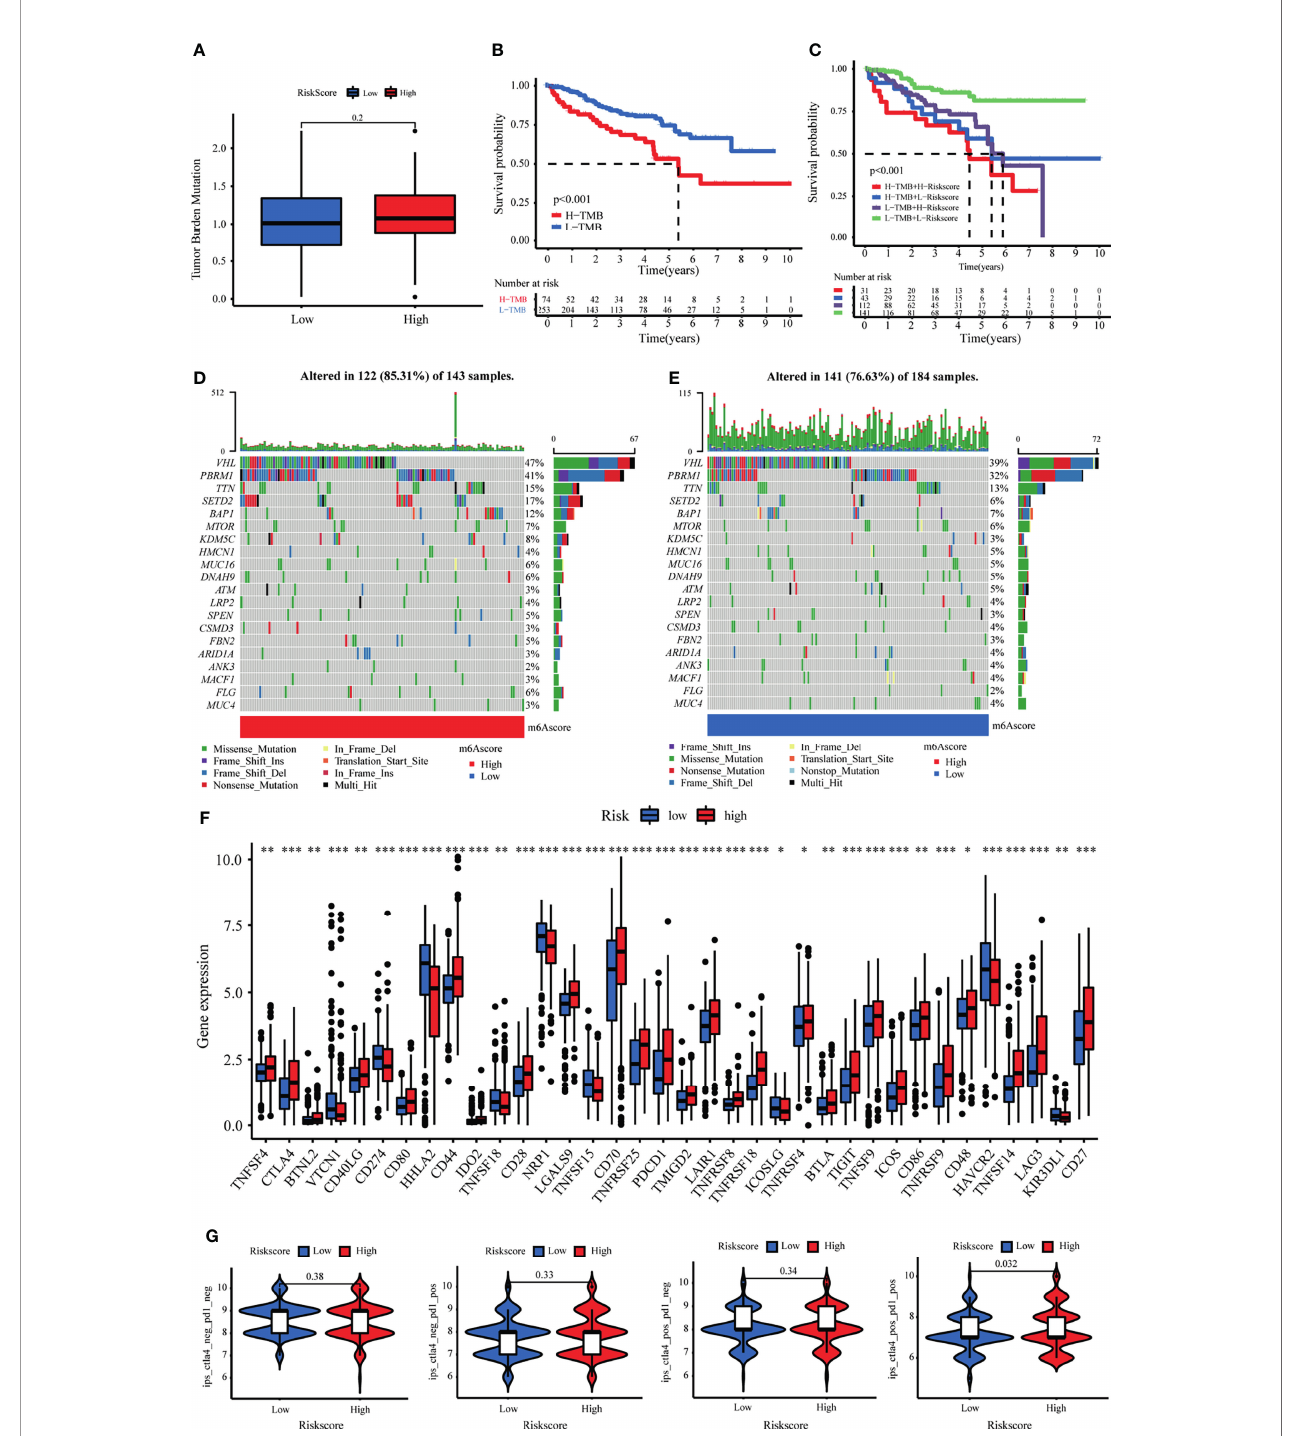
FIGURE 8 | Tumor mutational burden (TMB) and immunotherapeutic responses of the lactate-related prognostic signature (LRPS). (A) TMB between the low- and high-risk subgroups based on LRPS. (B) Survival analysis of the different groups strati fi ed by TMB. (C) Survival analysis of distinct groups strati fi ed by both TMB and LRPS. (D, E) Waterfall plot of tumor somatic mutation in the high- and low-risk groups. (F) Differences in the expressions of immune checkpoints between the low- and high-risk groups. (G) Comparison of the immunophenoscore (IPS) between the low- and high-risk groups strati fi ed by both CTLA4 and PD-1. * p < 0.05, ** p < 0.01, *** p <